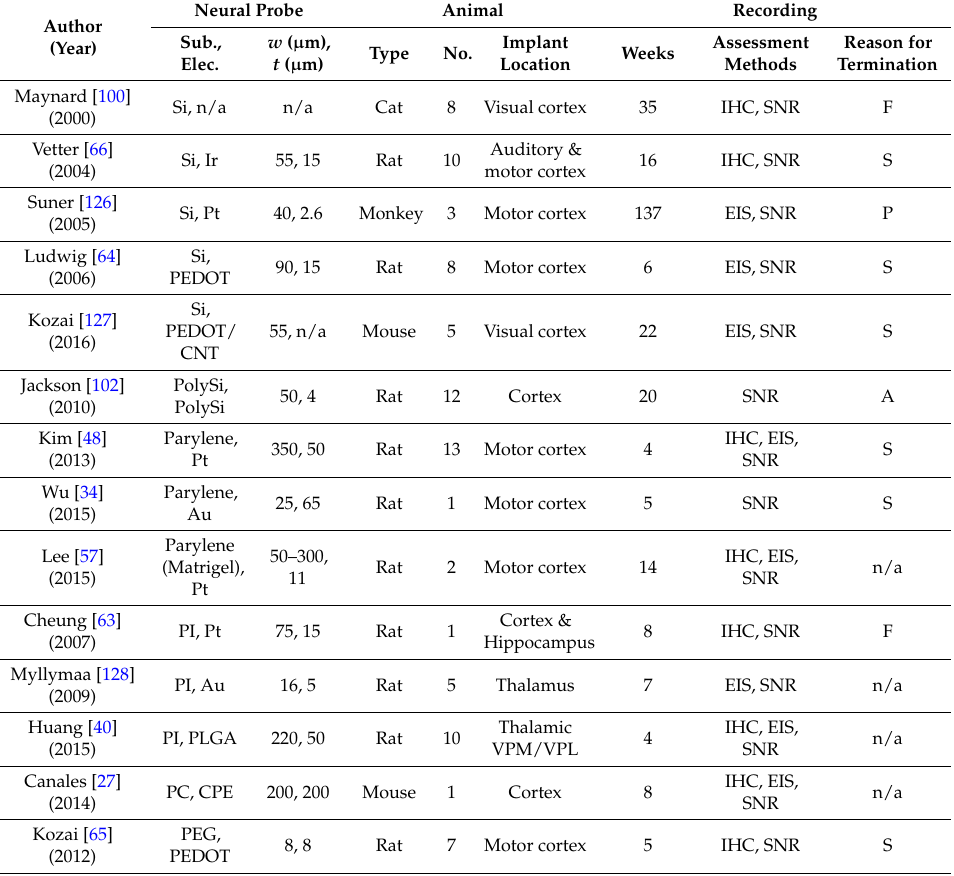
Table 4. Summary of neural probes with chronic recording